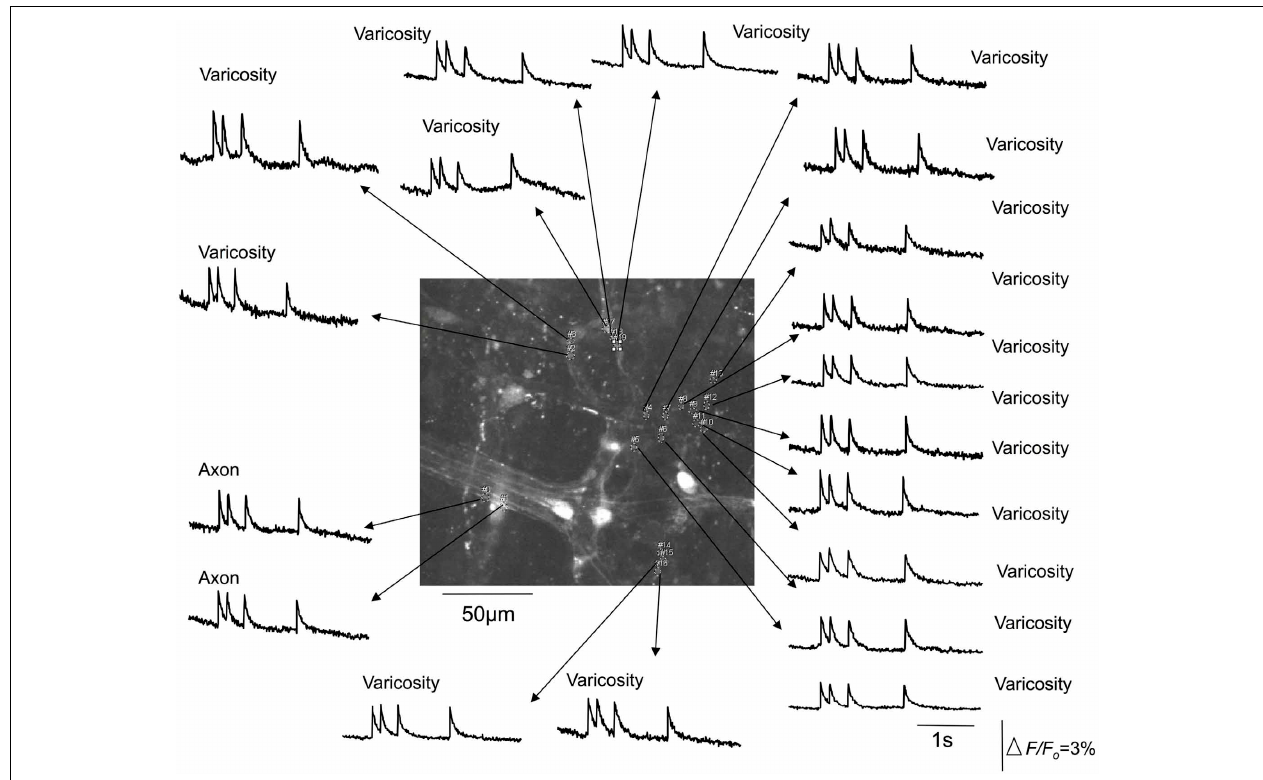
FIGURE 3 | Calcium transients in spinal afferent nerve terminals that ramify within a myenteric ganglia of a stretched segment of isolate mouse colon. Calcium transients discharge simultaneously in multiple varicosities that exist along a single axon. Note, the axon also generates